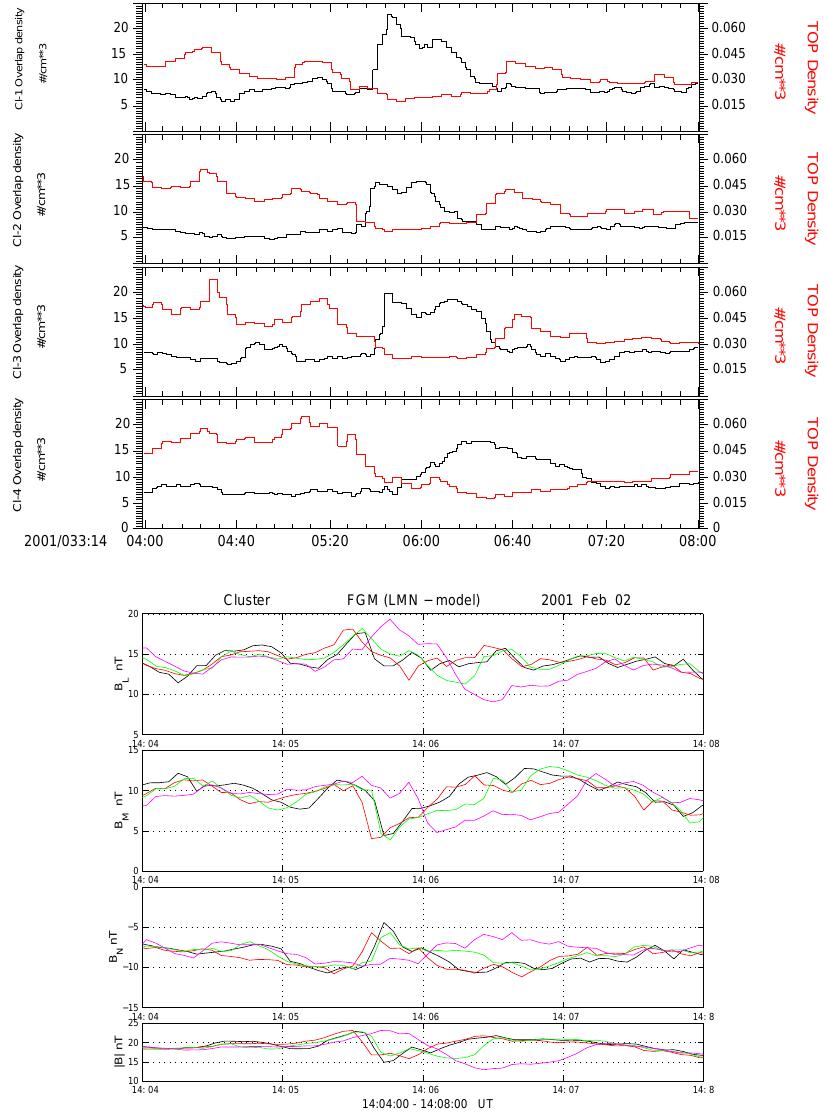
Fig. 5. (a) (Top 4 panels) Four spacecraft PEACE density moments for the period shown in Fig. 4 for electrons in the energy range of 34 eV–1.2 keV (black traces) and 1.2–26 keV (red traces). The former covers the typical energy range of magnetosheath electrons, the latter that of magnetospheric electrons. The rapid enhancement of magnetosheath electrons at C1, C2 and C3 is clearly seen. In addition, enhancements in the magnetospheric electrons are seen on either side of the observation of magnetosheath electrons, with a dropout in the middle. C4 sees a delayed enhancement of magnetosheath electrons, and no enhancement of magnetospheric electrons on the trailing edge. (b) (Lower 4 panels) The LMN magnetic field components and field strength observed by the 4 Cluster spacecraft (C1 - black, C2 - red, C3 - green, C4 - magenta trace) during this period. The field strength is slightly enhanced at each spacecraft immediately prior to the arrival of the magnetosheath electrons. The B N component shows a brief positive and then more extended negative deflection, which is consistent with the expected signature of a magnetospheric